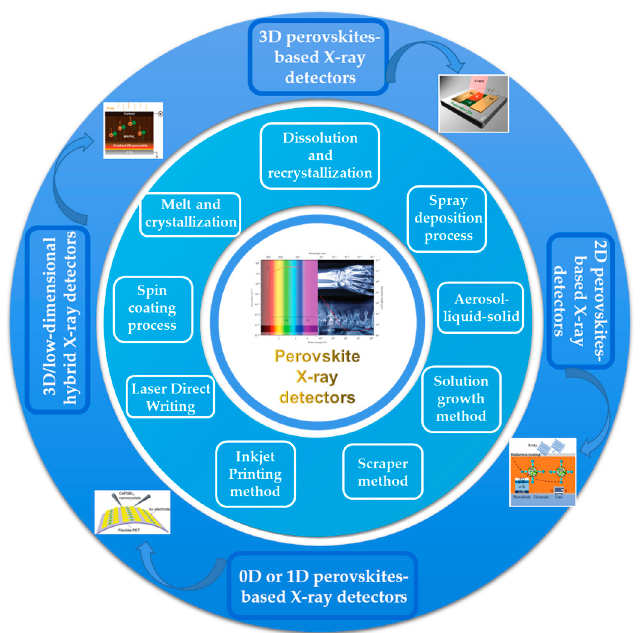
Figure 1. Progress in X-ray detectors based on halide perovskite materials.